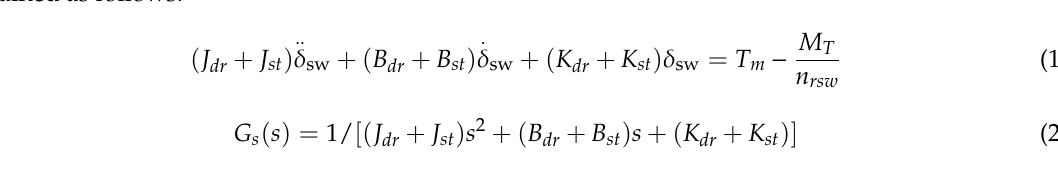
Table 1. Parameters of driver neuromuscular (NMS) model.